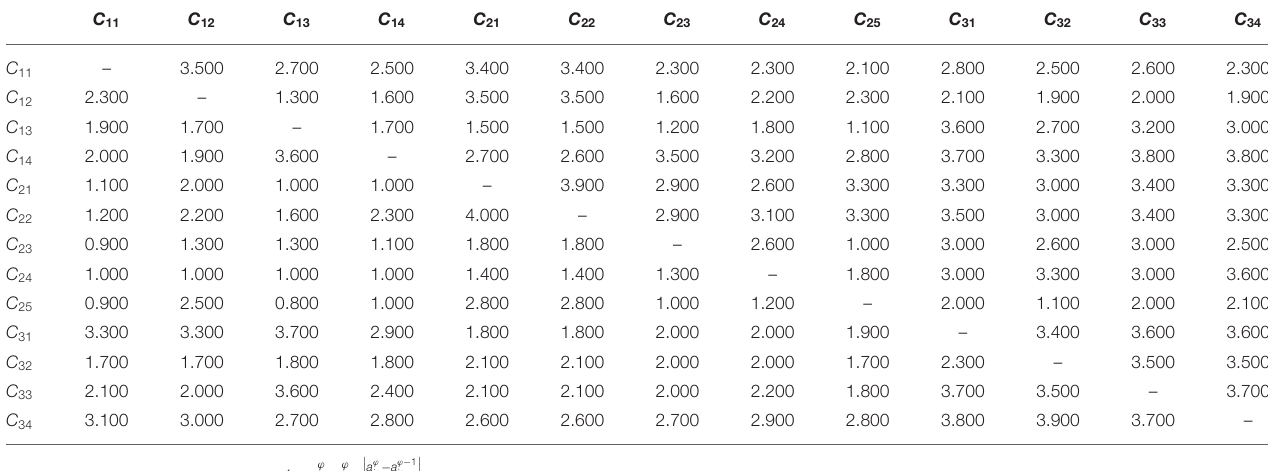
TABLE 2 | The initial influence-relationship